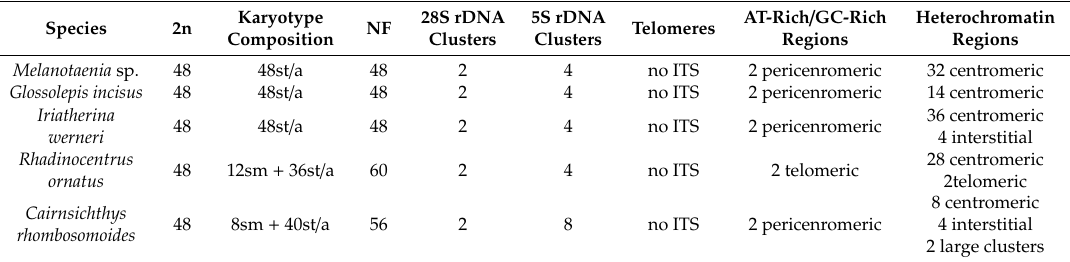
Karyotype 28S rDNA 5S rDNA AT-Rich / GC-Rich Heterochromatin NF Telomeres Composition Clusters Clusters Regions Regions